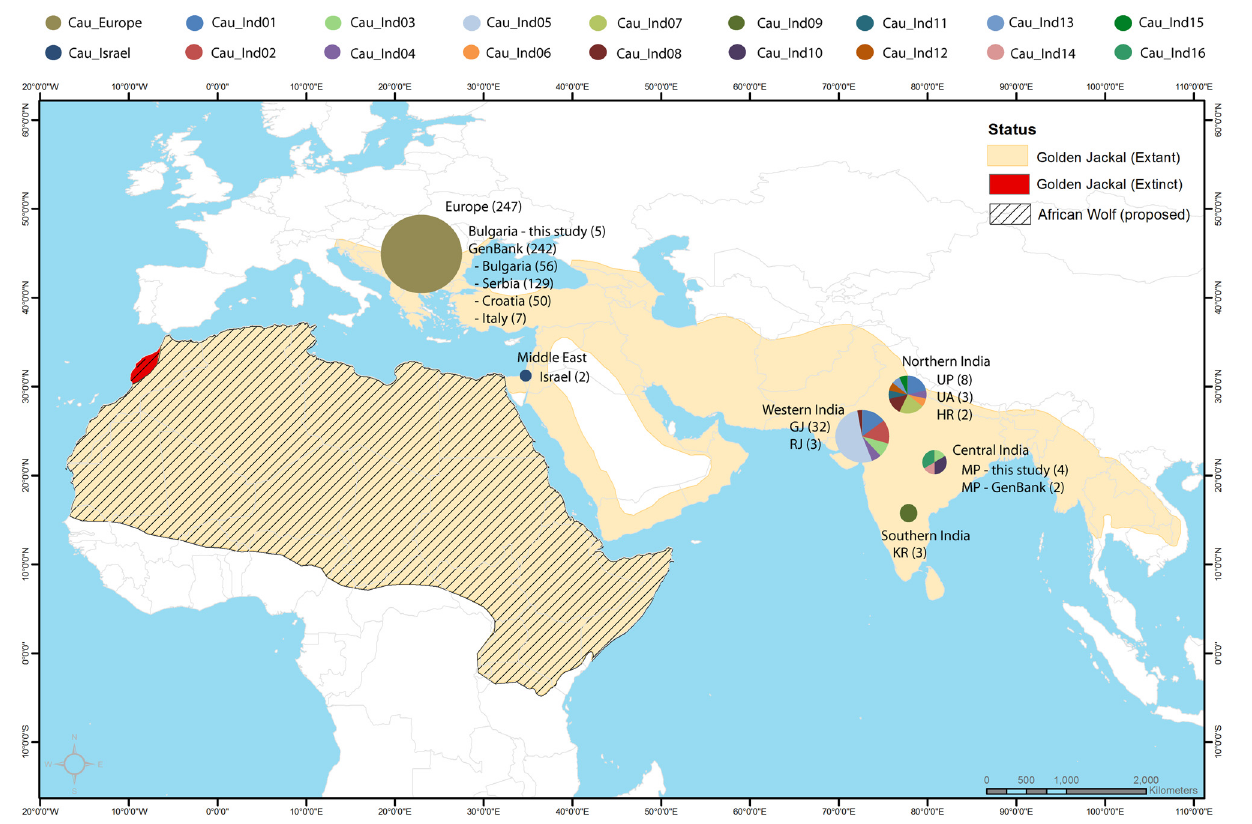
Fig 1. Map showing golden jackal range and geographic distribution of mtDNA control region haplotypes. Pie charts are proportional to haplotype frequency in each area. The distribution of the African wolf (or African golden jackal) is putative and based on recent studies in North Africa [11, 12, 13], which observed cryptic speciation or introgression of gray wolf mtDNA lineages within golden jackals and wolf-jackal hybrid phenotypes, implying that the African wolf (gray wolf mtDNA clade) likely co-occur in the same area as the golden jackal in Africa. The golden jackal distribution map was obtained as a shape-file from the IUCN species database (http://maps.iucnredlist.org/map.html?id=3744, Accessed 4 June 2014), while the base geographic layer was downloaded from the NaturalEarth database (www.naturalearthdata.com, Accessed 4 June